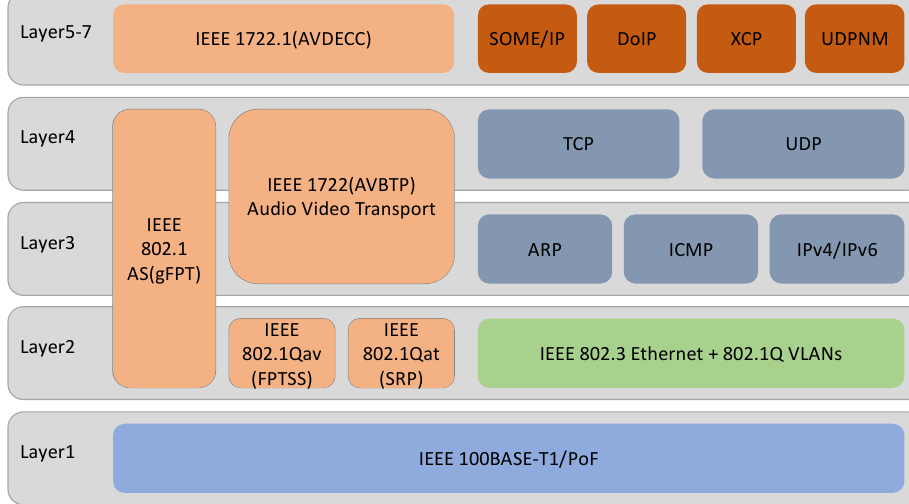
Figure 3. Automotive Ethernet and its upper-layer protocol architecture.